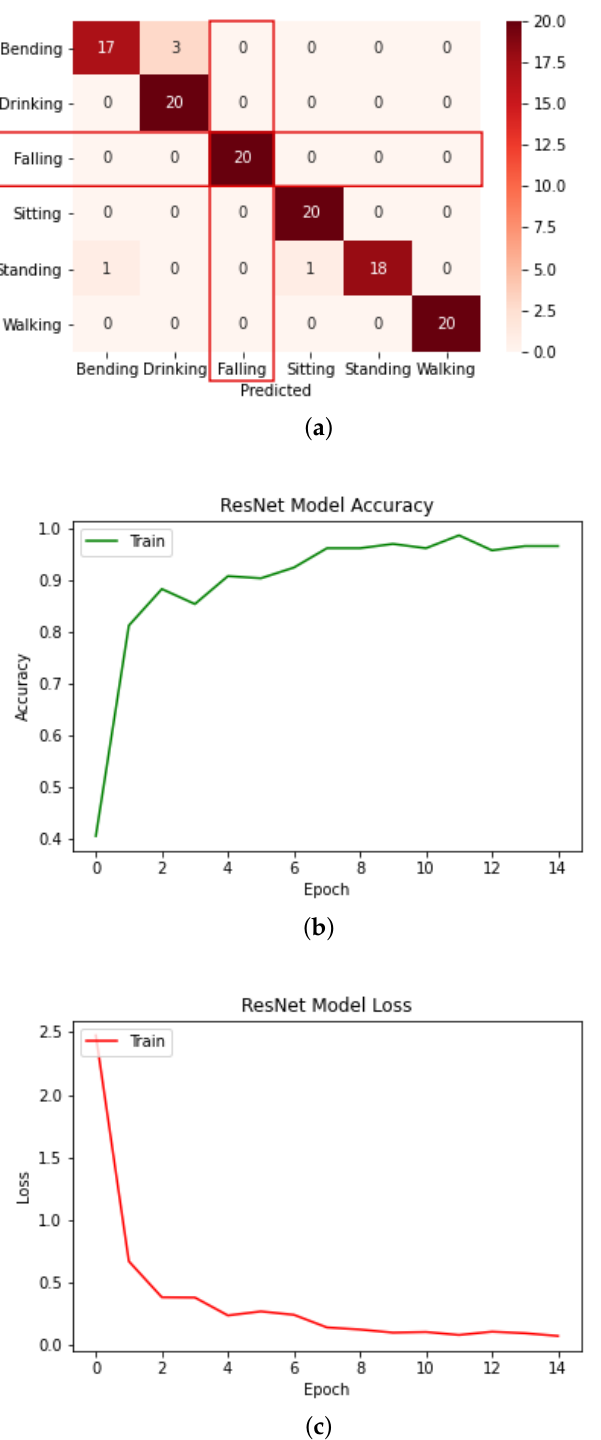
Figure 6. Experiment 1 results: ( a ) confusion matrix, ( b ) ResNet model accuracy, and ( c ) loss versus number of